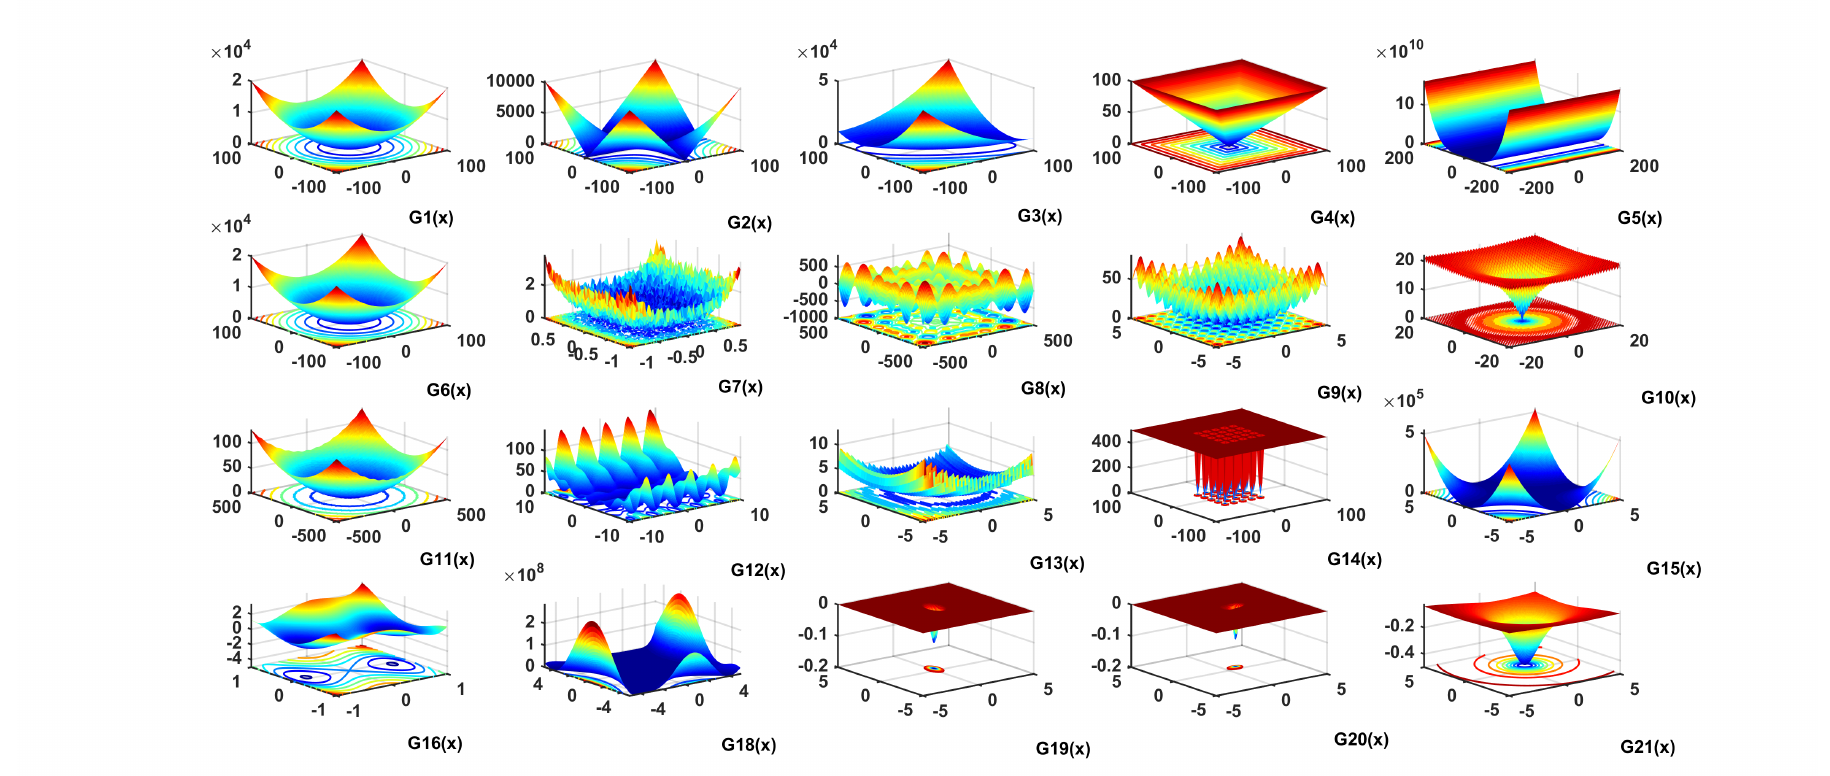
Figure 4. Benchmark Suite